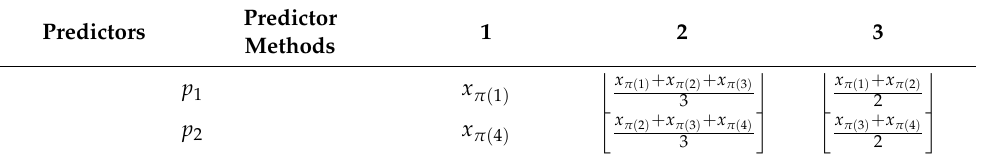
Table 1. Three different predictor